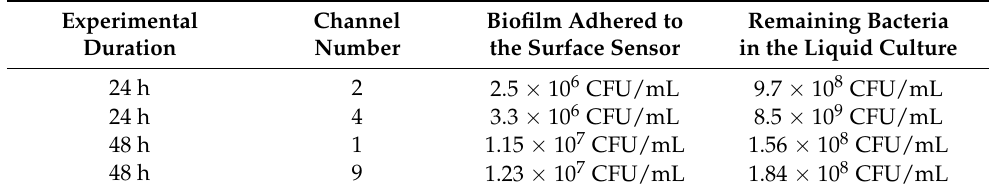
Table 1. Bacterial concentrations of both the biofilm adhered to the QCM sensor surface and the planktonic culture at the end of the experiments.